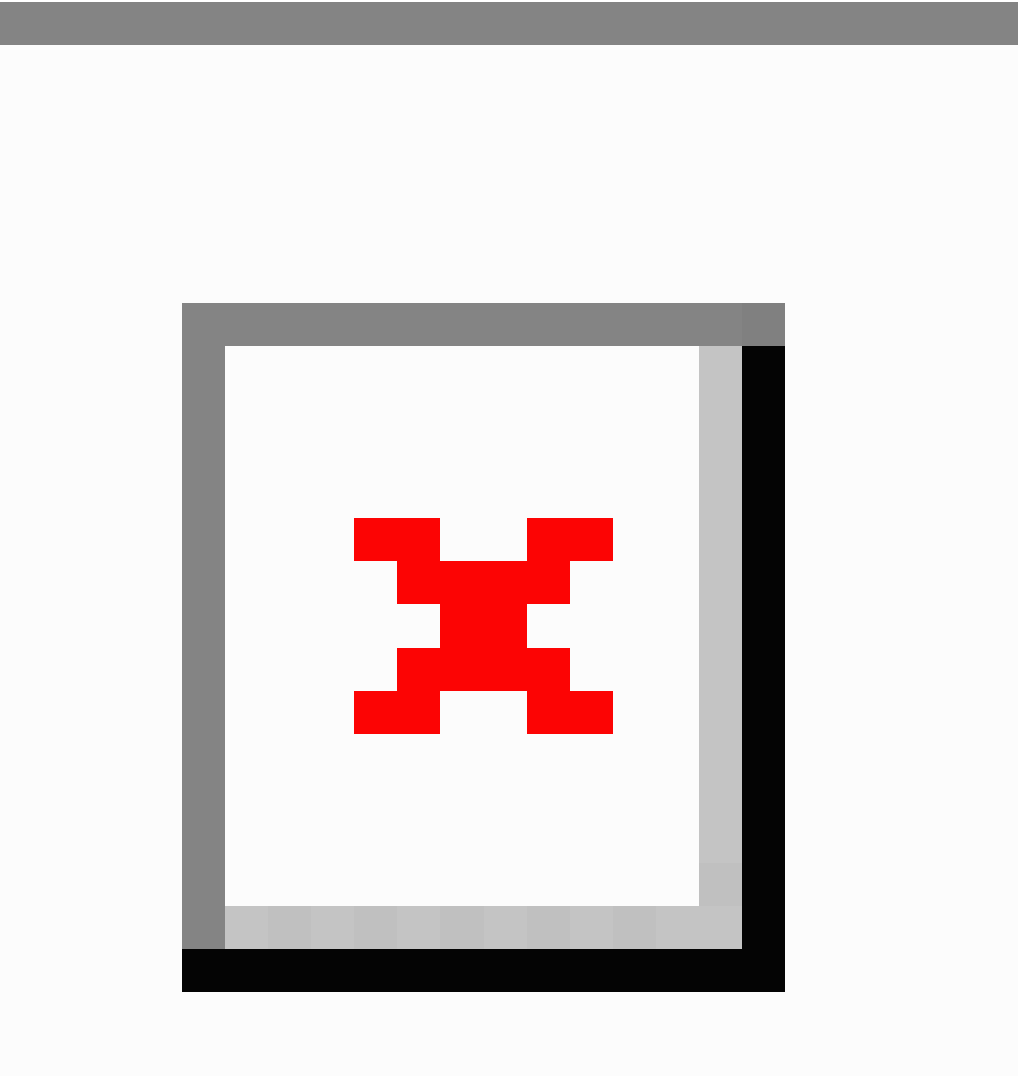
Figure 2. Example of a “tagged crop” task in which one or more selections within an image are associated with a tag, and multiple tags can be defined in a single